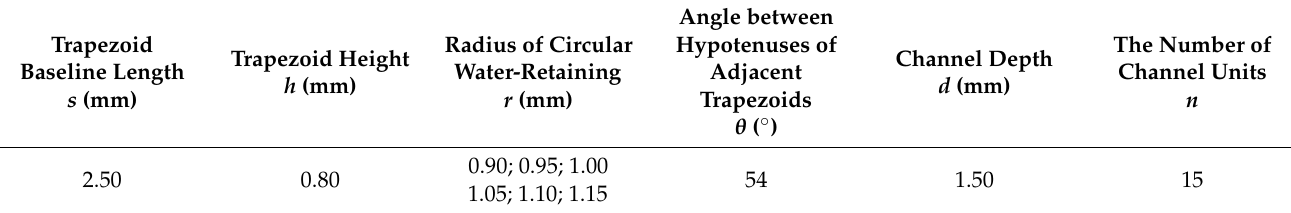
Figure 2. Three-dimensional physical model of the CWRLC emitter. Table 1. Structural parameters and settings for the CWRLC emitter flow channel.